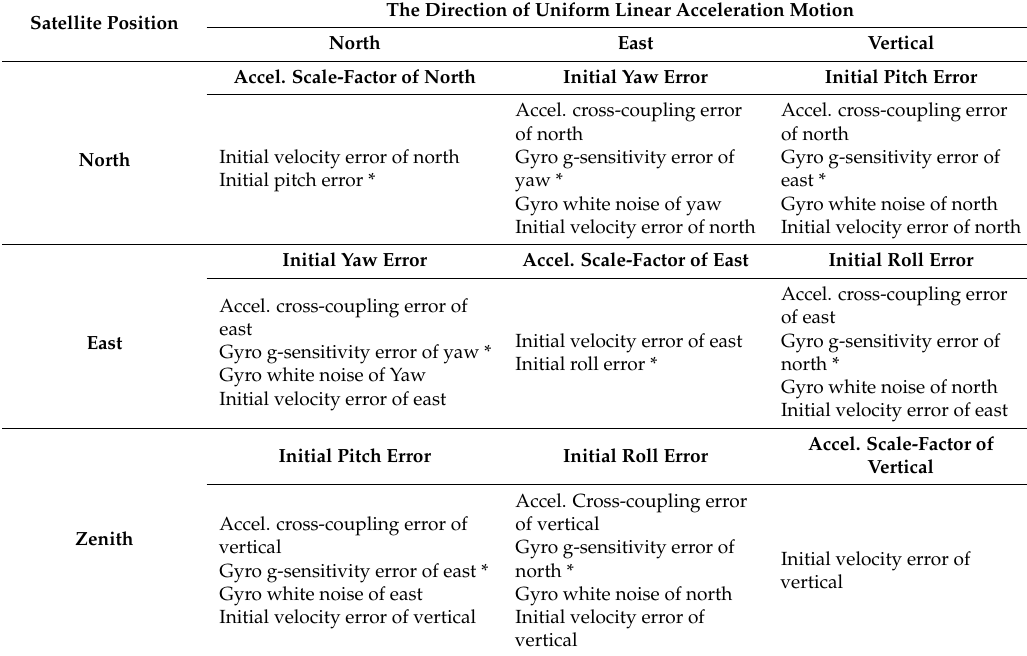
Table 3. The main error sources affect the tracking performance in linear high dynamics. The Direction of Uniform Linear Acceleration Satellite Position